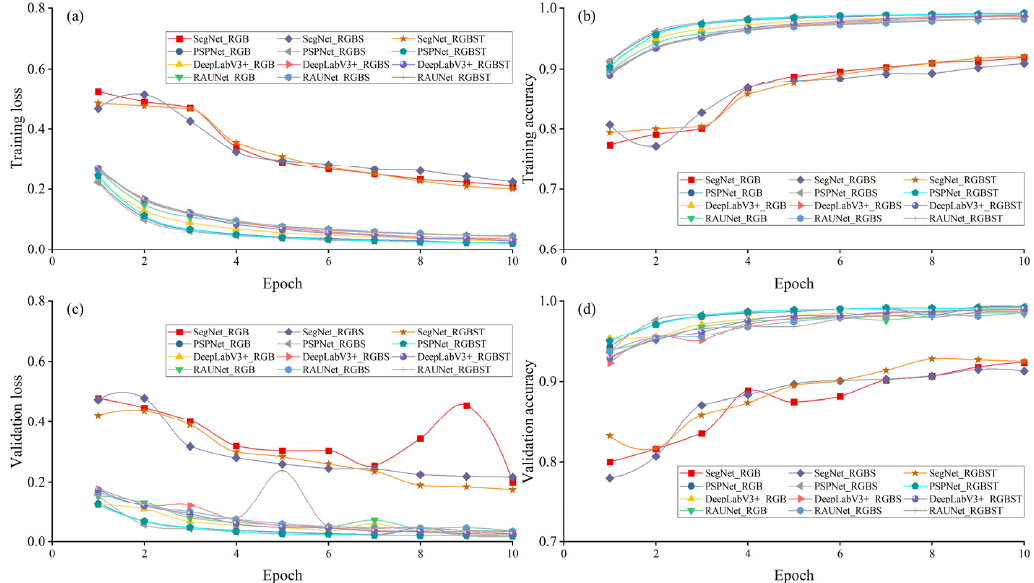
Figure A2. Training and validation curves for one-class classification of KH. ( a ) training loss; ( b ) training accuracy; ( c ) validation loss; ( d ) validation accuracy.